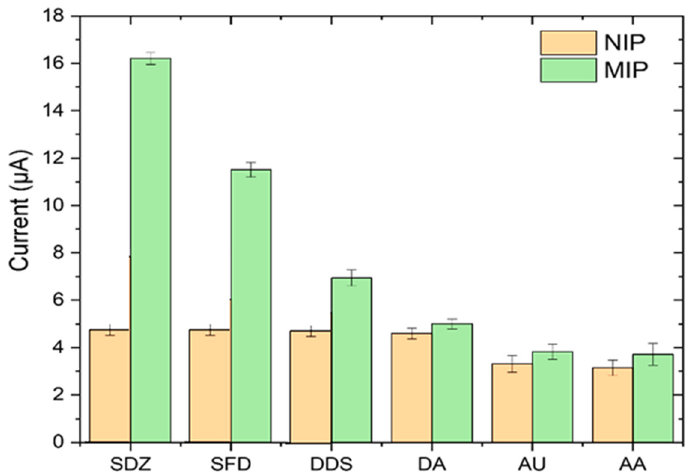
Figure 14. DPV response for sulfadiazine and its interfering molecules by the MIP and NIP sensors.